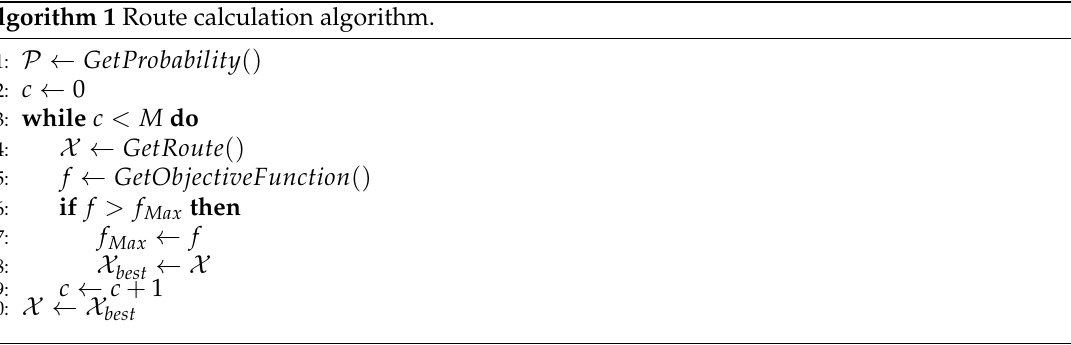
Algorithm 1 Route calculation